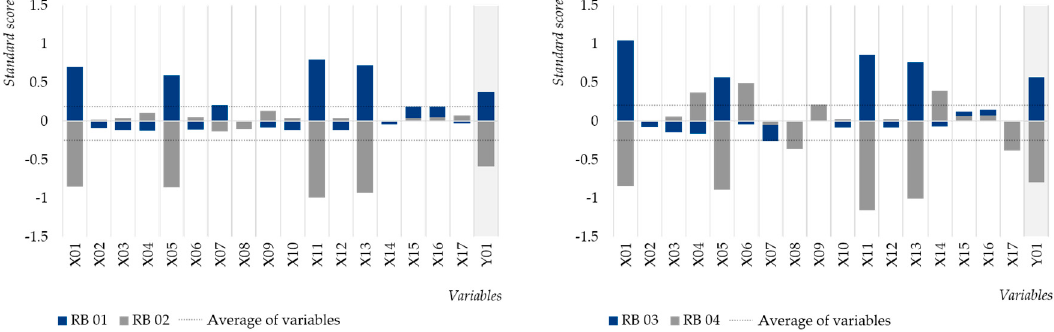
Figure 3. Cluster profile based on variables ( left : method 1, right : method 2).